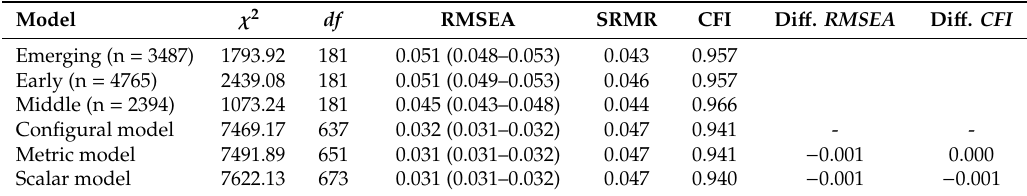
Table 4. Analysis of invariance across age groups: emerging, early and middle